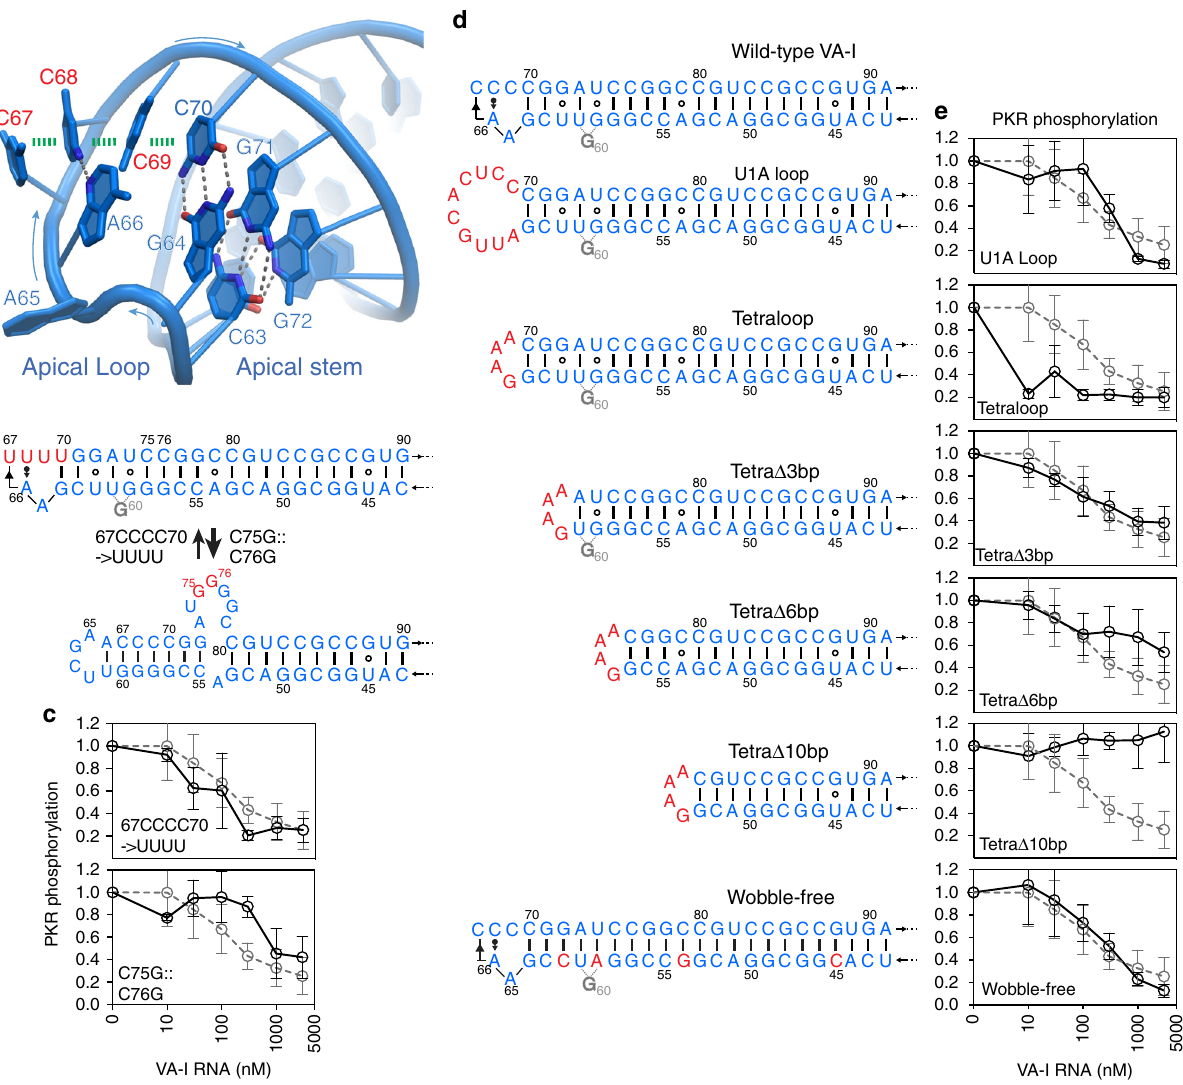
Fig. 2 Structure and mutational analysis of VA-I apical region. a Apical region structure. The single-stranded, stacked C67 – C69 in a dsRNA-like helical arrangement is indicated with red labels. Hydrogen bonds are denoted by gray dashed lines and base-stacking interactions are shown as green dashes. b Proposed alternative conformations of the apical region. The 67CCCC70 → UUUU substitution stabilizes the canonical conformation (upper panel) while a C75G::C76G substitution stabilizes the alternative, bulged conformation (lower panel). c Effects of the substitutions in b on PKR inhibition. The WT VA-I titration curve is shown as gray dashed lines for comparison in these and subsequent panels. d Secondary structures of wild-type and mutant VA-I RNAs harboring alterations to the apical loop, apical stem length, or the removal of apical stem wobble base pairs. The central domain is omitted for clarity. e Effects of VA-I alterations in d on PKR inhibition. Error bars represent s.d. from three independent